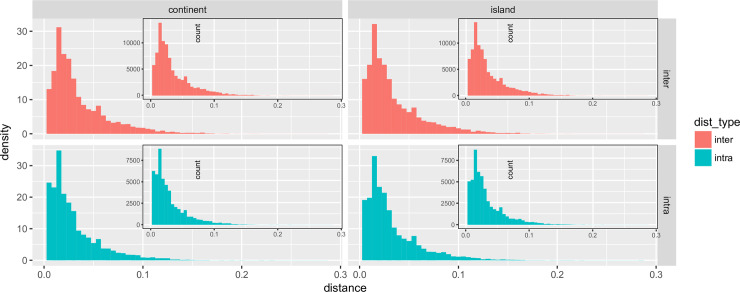
Density histogram of inter- and intra-zone distances according to study region (“continent” or “island”).Inter-zone distance: red; intra-zone distance: blue. Species found in both continental and island areas were excluded. For each plot the corresponding count histogram is plotted as inset.